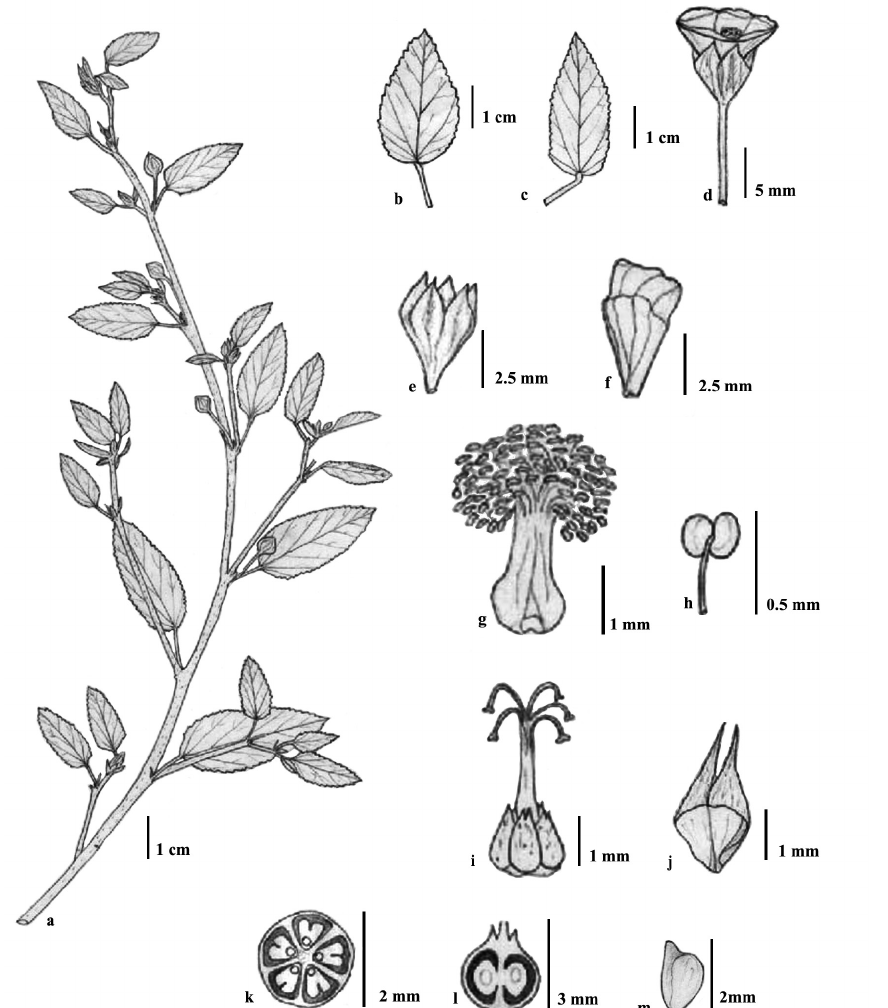
Figure 1. Sida ravii . a - Habit; b&c - Leaf; d - Flower; e - Calyx; f - Coralla; g - Staminal Column; h - Stamen; i - Pistil; j&k - Ovary t.s & l.s; l - Mericarp; m - Seed